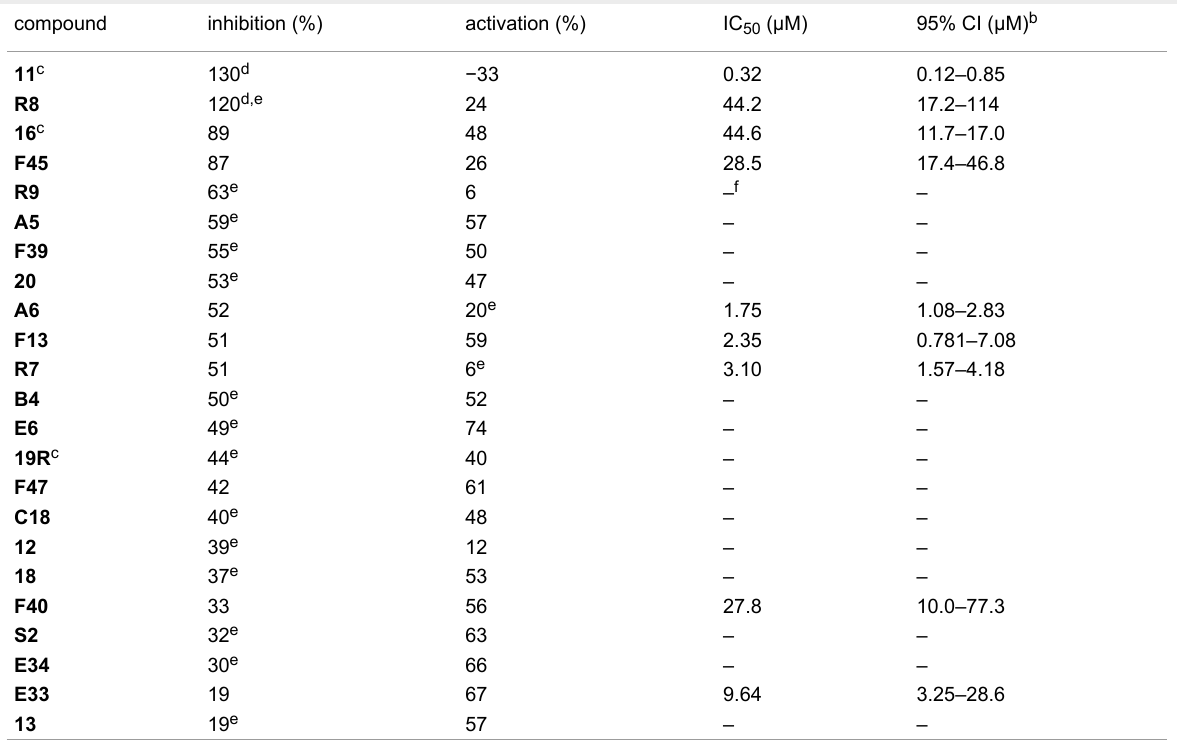
Table 3: Characterization data for SdiA antagonists (listed by efficacy). a